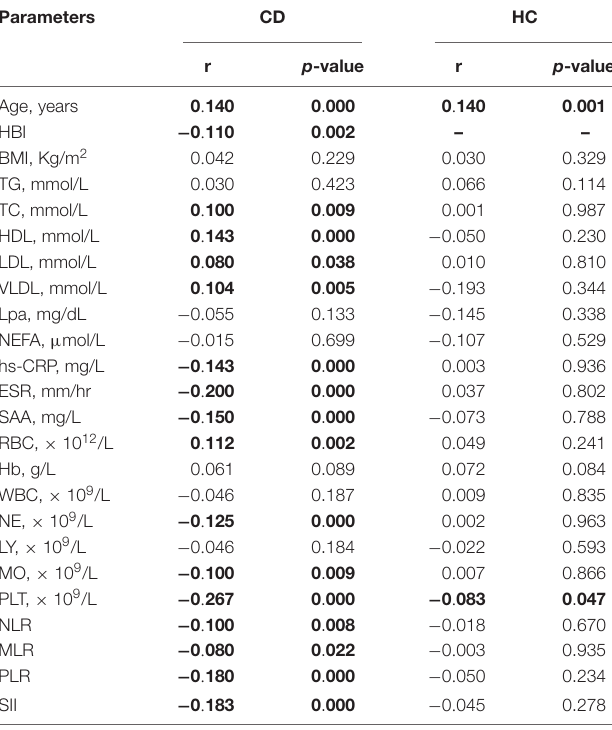
TABLE 4 | Correlation of serum 25(OH)D concentration with lipid profiles and inflammatory biomarkers.